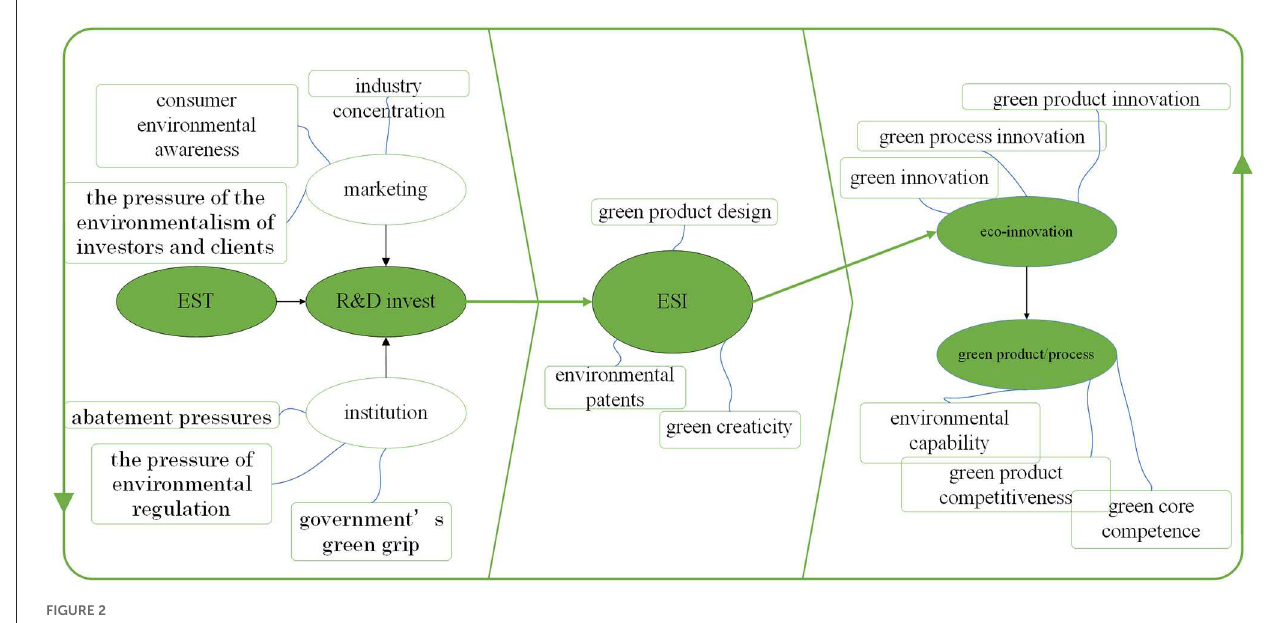
FIGURE2 Concepts and their relationships related to